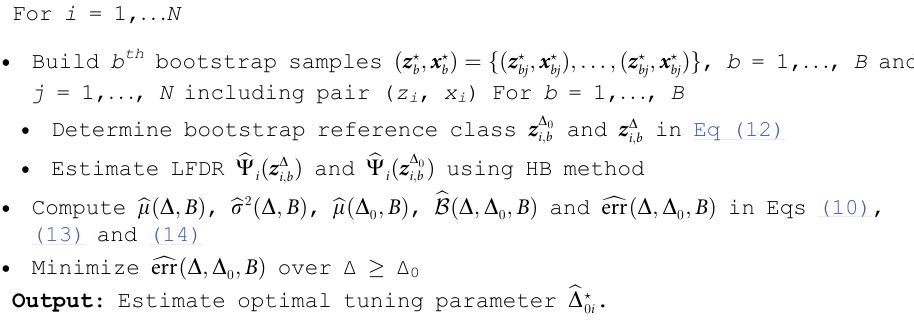
Algorithm 1 Pseudo-code of the estimation of the optimal tuning parameter for one simu- lated